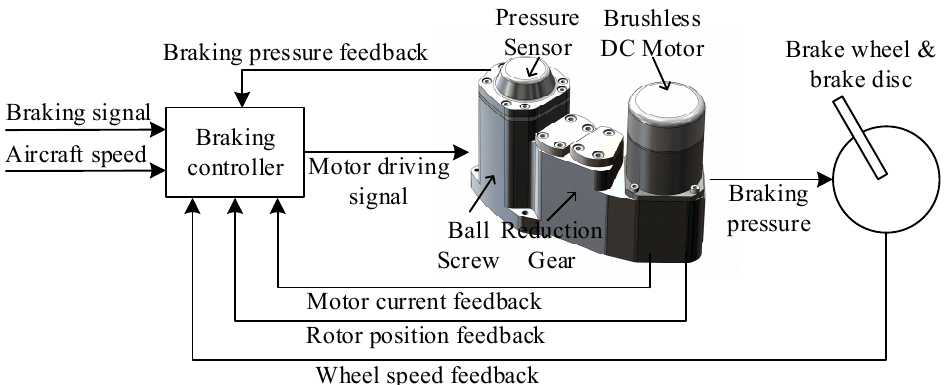
Figure 1. Structure of the electric braking system in aircraft.